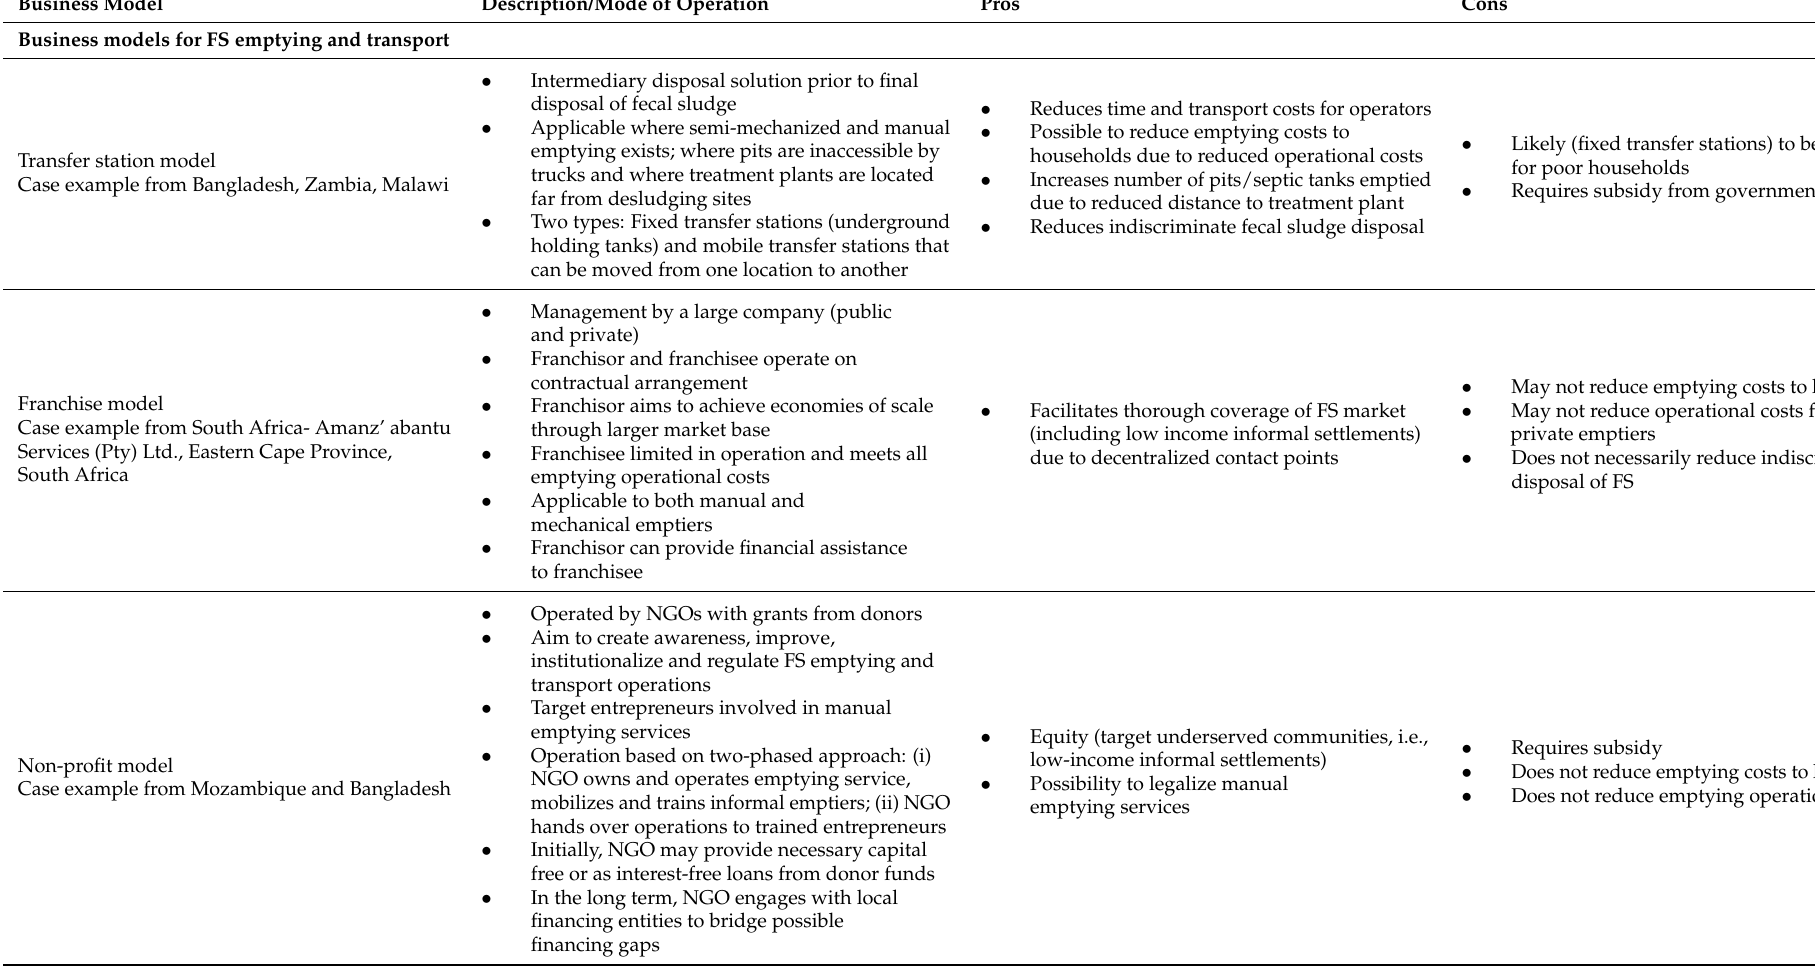
Table 3. Analysis of alternative business models for FS emptying and transport in informal settlements adapted from